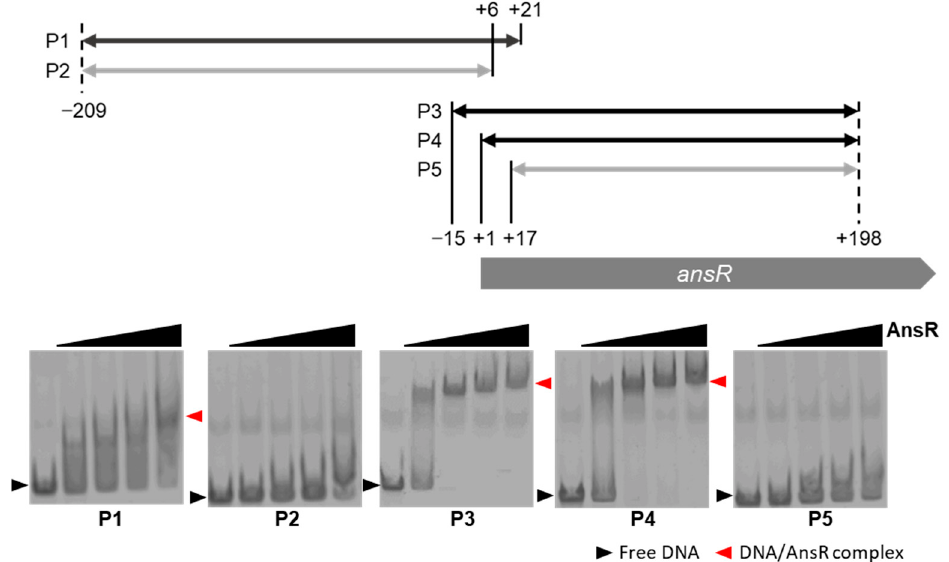
Figure 4. Electrophoretic mobility shift assay using His-tagged AnsR. The DNA probes (P1 to P5) encompassing the upstream or intragenic region of the ansR gene are indicated. The DNA probes interacting with AnsR are indicated in black, while those without interaction are indicated in grey. The DNA probes (10 nM) were incubated with varying amounts of His-tagged AnsR (0.2–1.6 µ M). The free probes and AnsR-DNA complexes are indicated with black and red arrowheads, respectively.